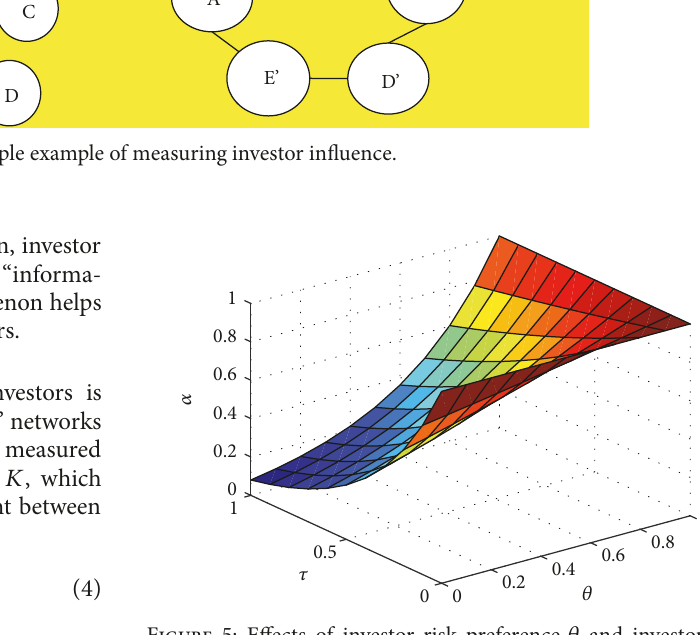
Figure 5: Effects of investor risk preference 𝜃 and investor risk cognitive level 𝜏 on investor transformation probability 𝛼 when V 0 = 0.4 𝜆 = 0.2 𝑖